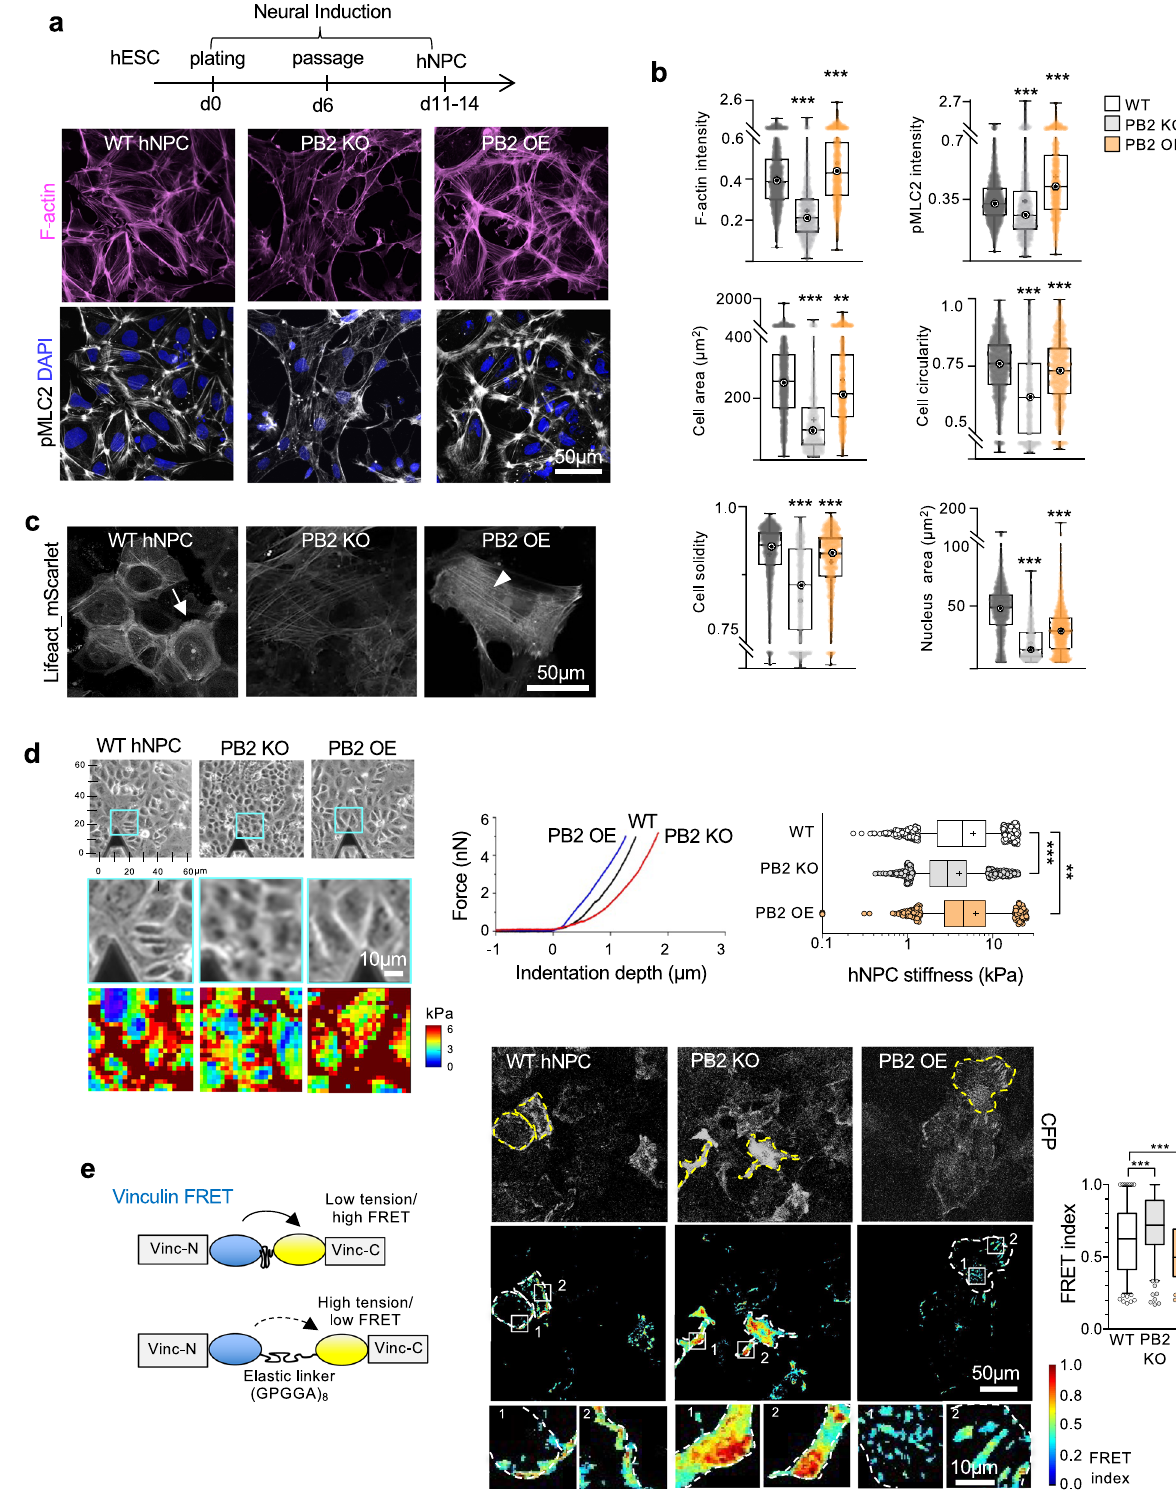
and matrix. We performed total internal re fl ection fl uorescence (TIRF) microscopy for morphometric analysis of FAs visualized by paxillin IF (Fig. 5a, b). In both hESCs and hNPCs, we observed increased numbers of FAs with PLXNB2 OE. In addition, both the size and the shape of FAs were also altered, with generally